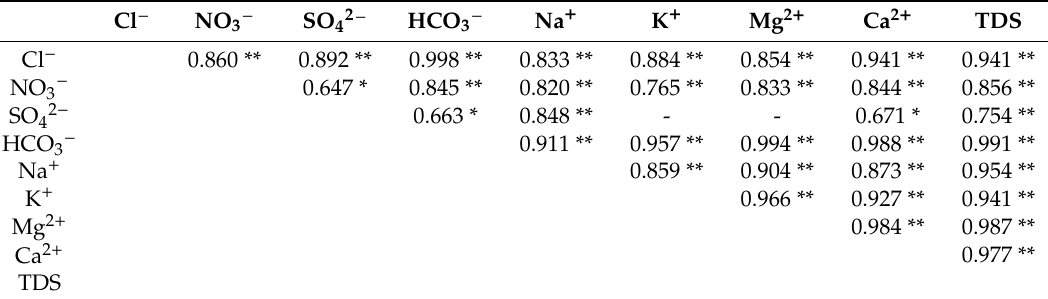
Table 4. Pearson correlation coe ffi cients for hydrochemistry parameters of glacial